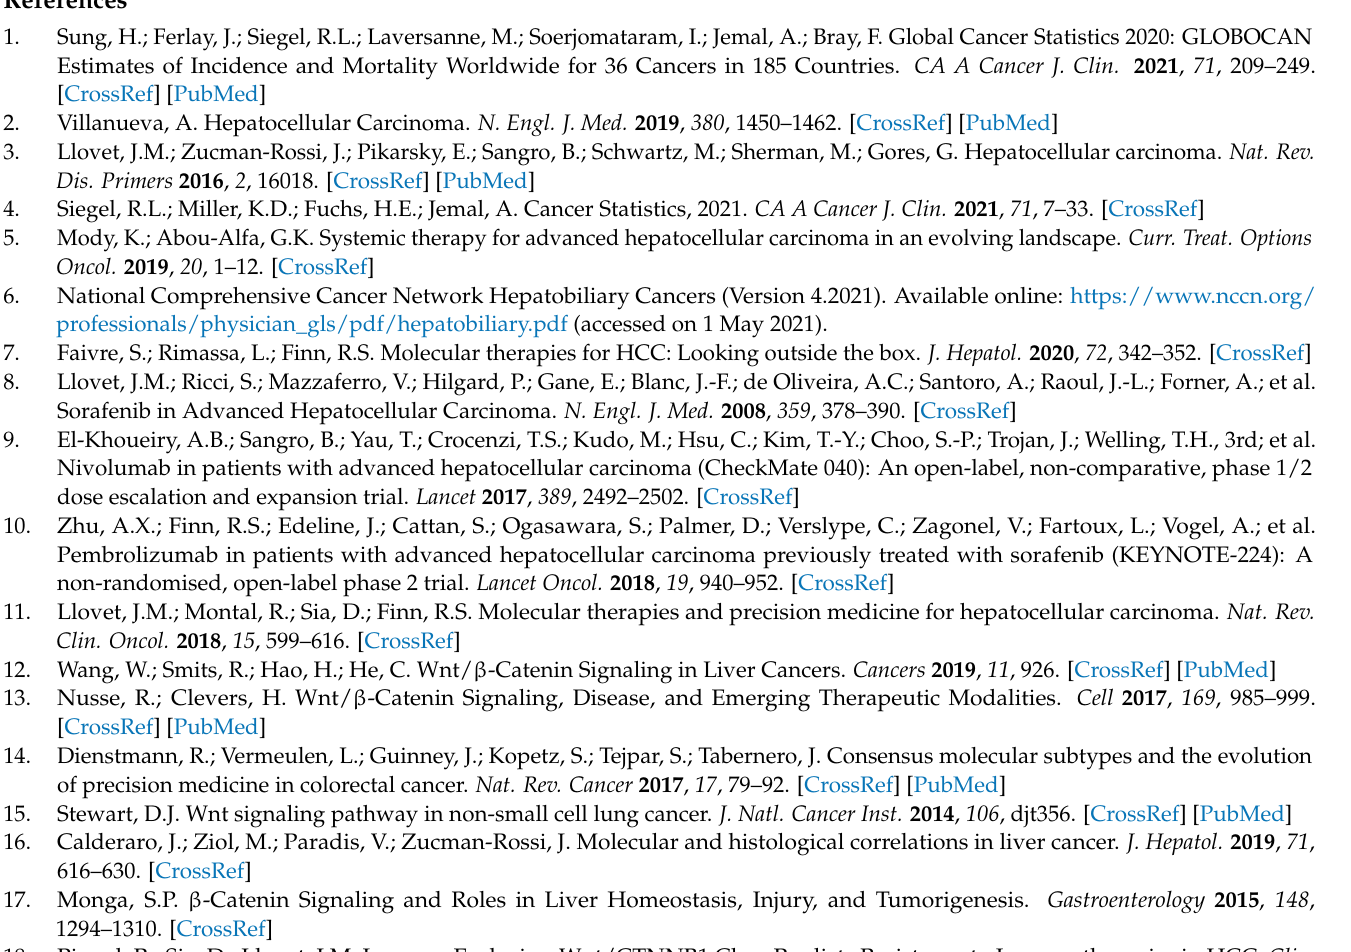
Figure S2: Changes in pathway proteins related to cytochrome C, APAF1, and caspase signaling in HepG2 and Huh7 liver cancer cells treated with